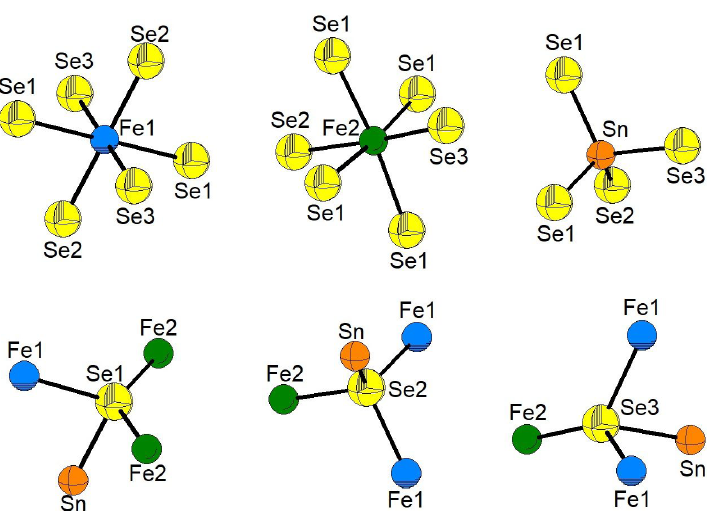
octahedra, SnSe 6